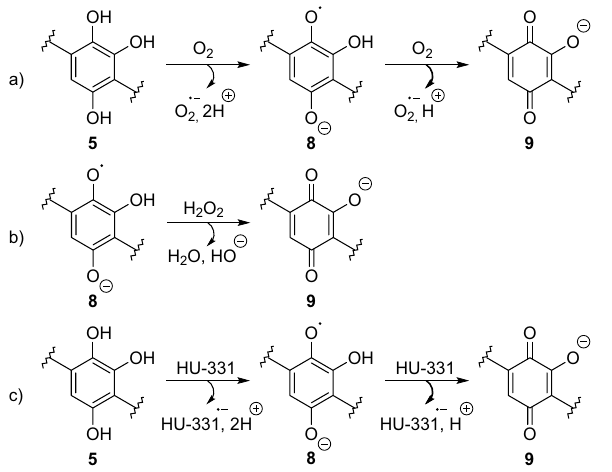
Figure 4. Formation and reaction of hydroxyquinol 5 and related products in CBD